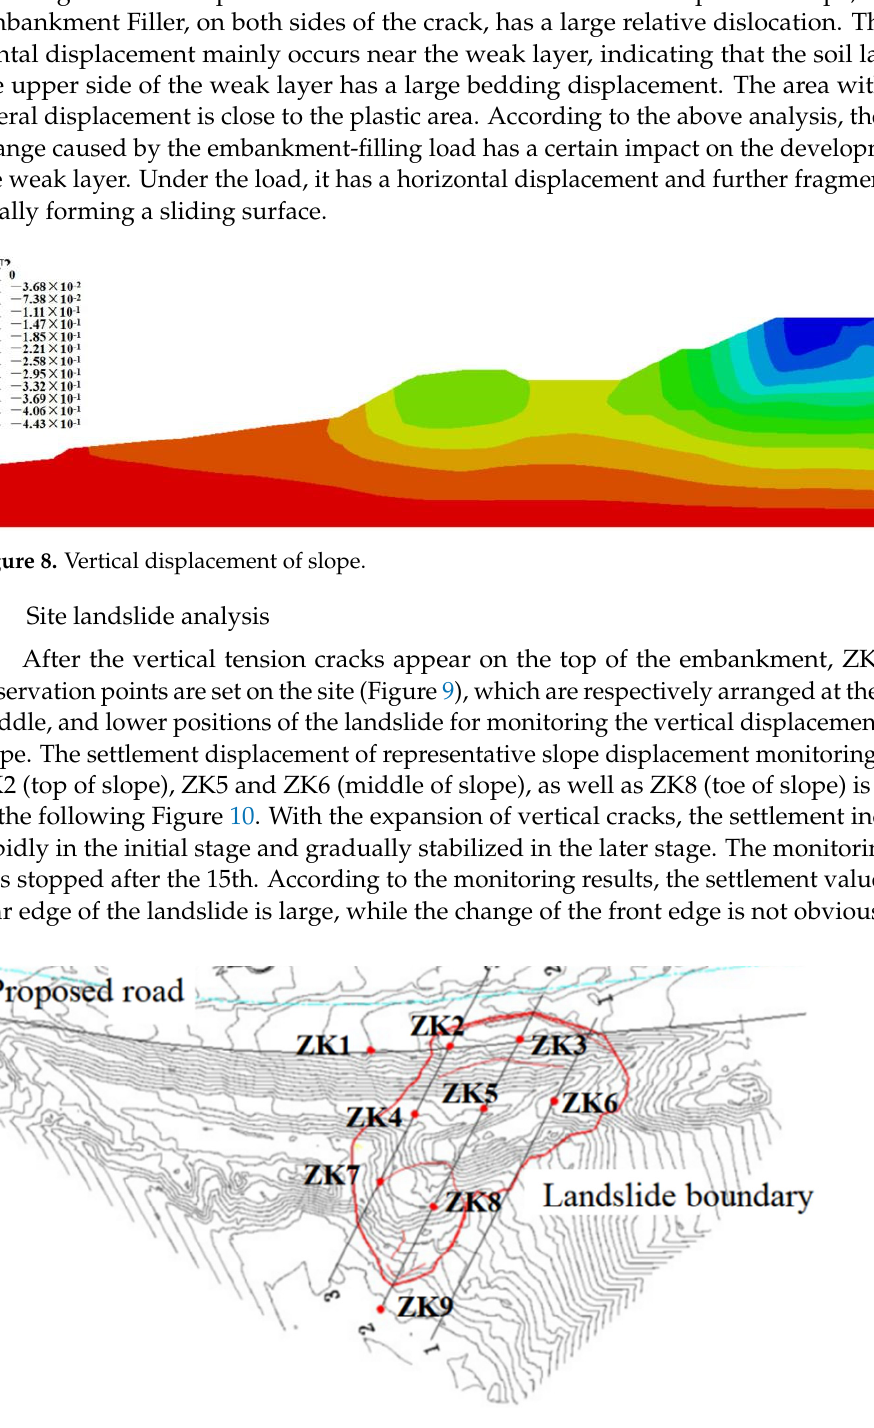
Figure 7. Slope plastic zone.